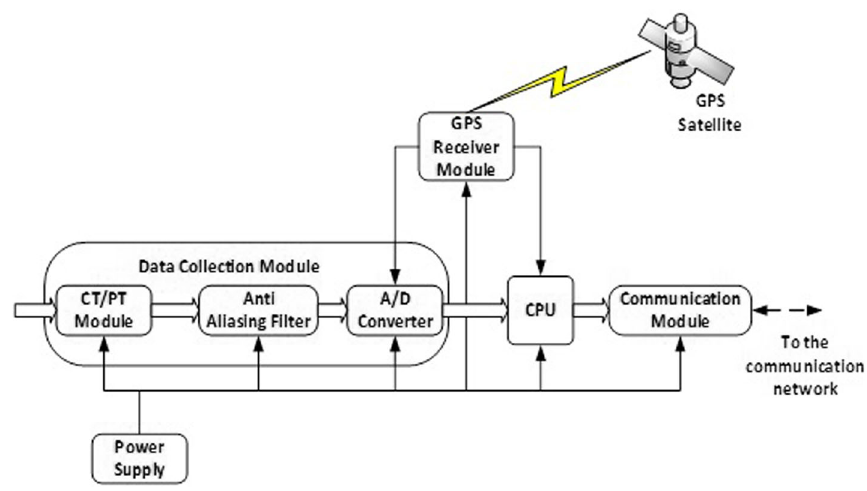
Fig. 5 The various functional blocks in the